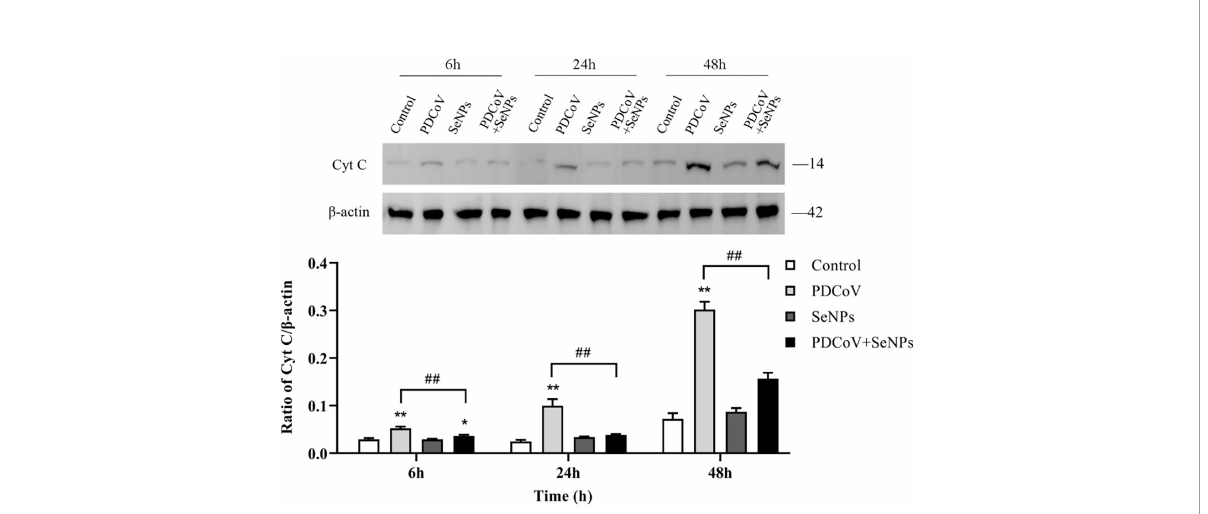
FIGURE 9 Effects of SeNPs on Cyt C content in the cytoplasm of ST cells infected with PDCoV. Top is immunoblot bands of Cyt C in each treatment group at 6, 24, and 48 h. At the bottom is a histogram after analyzing and calculating the ratio of grayscale values of Cyt C. * indicates that the difference is signi fi cant compared with the control group (P < 0.05), ** indicates that the difference is extremely signi fi cant compared with the control group (P < 0.01); ## indicates that there is a signi fi cant difference between the PDCoV group and the PDCoV + SeNPs group (P < 0.01), and there is no signi fi cant difference (P > 0.05) in the unlabeled expression,